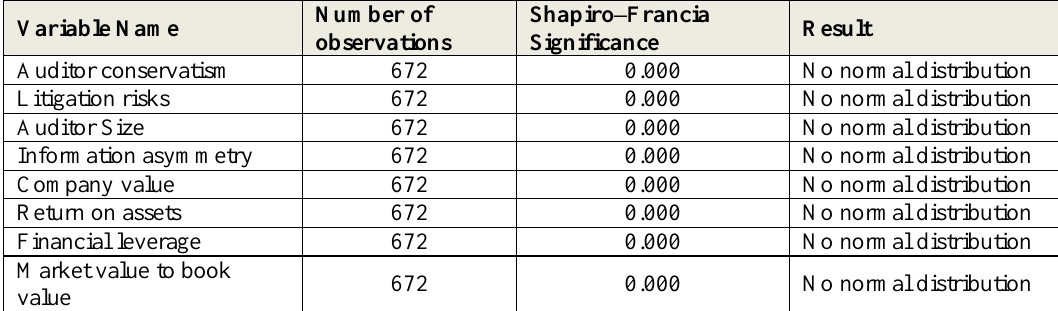
Table 3. Shapiro–Francia Test Results